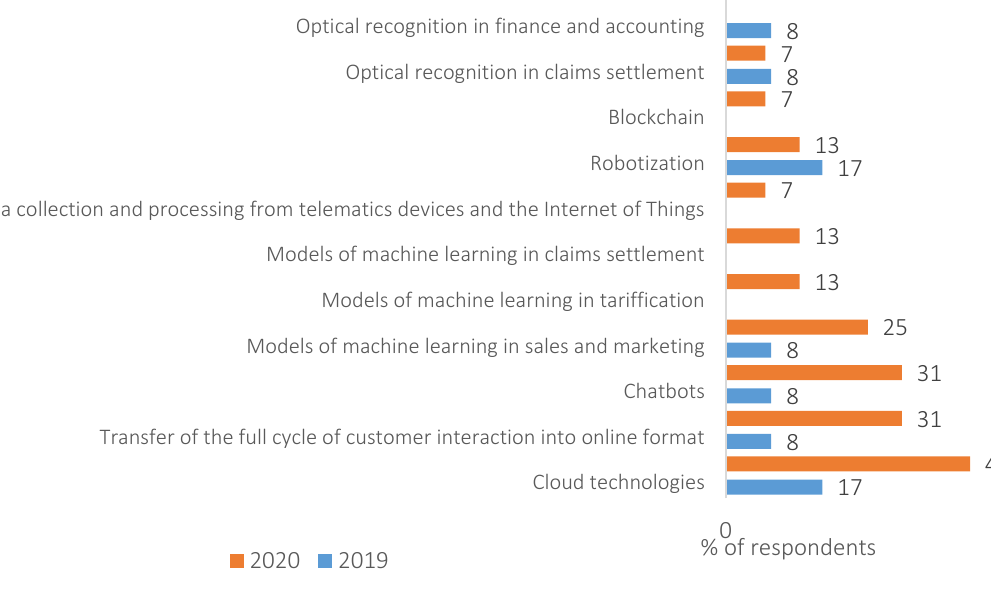
Figure 2. The use of new technologies by Russian insurance companies (at the stage of the full